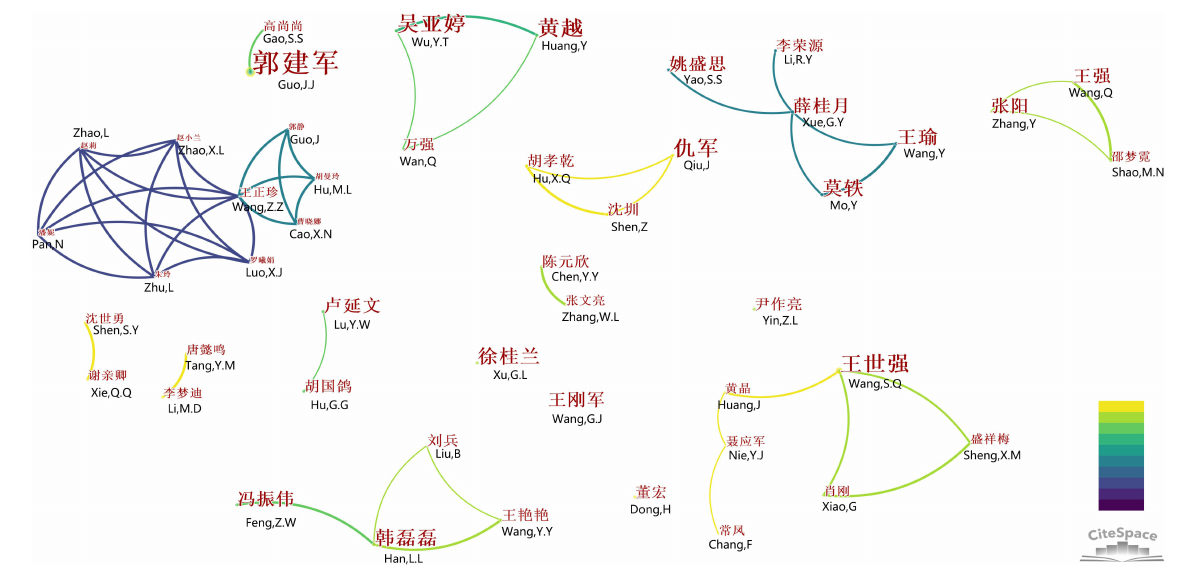
FIGURE3 Bibliometric analysis of the authors of publications on fusion of sports and medicine in China from 2012 to 2021. Each node represents an author, the bigger the node the author had more publications. The line indicated the relationship between authors, the thicker the closer relationship, the lighter the later relationship were formed. The English was translated from the original figure yielded by CiteSpace.